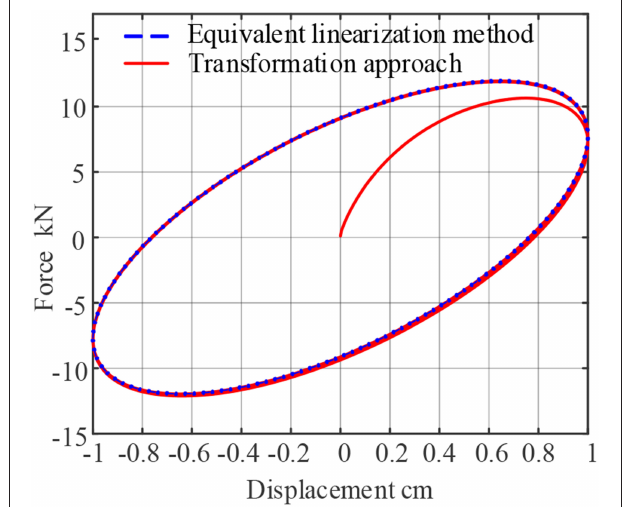
FIGURE 2 | Force-Displacement curve of viscoelastic resistance under harmonic